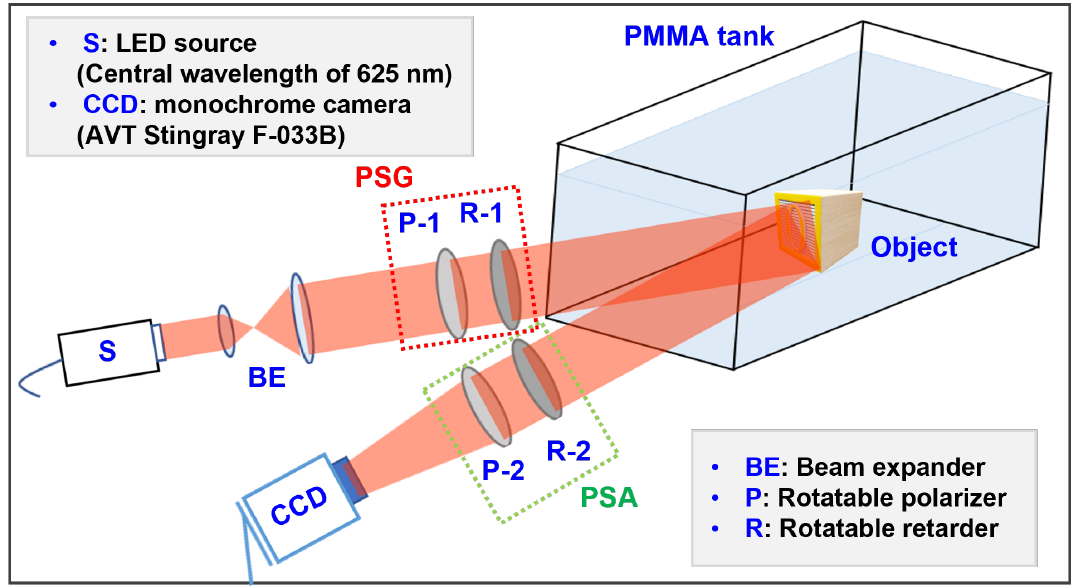
Figure 2. Experimental setup of the MM